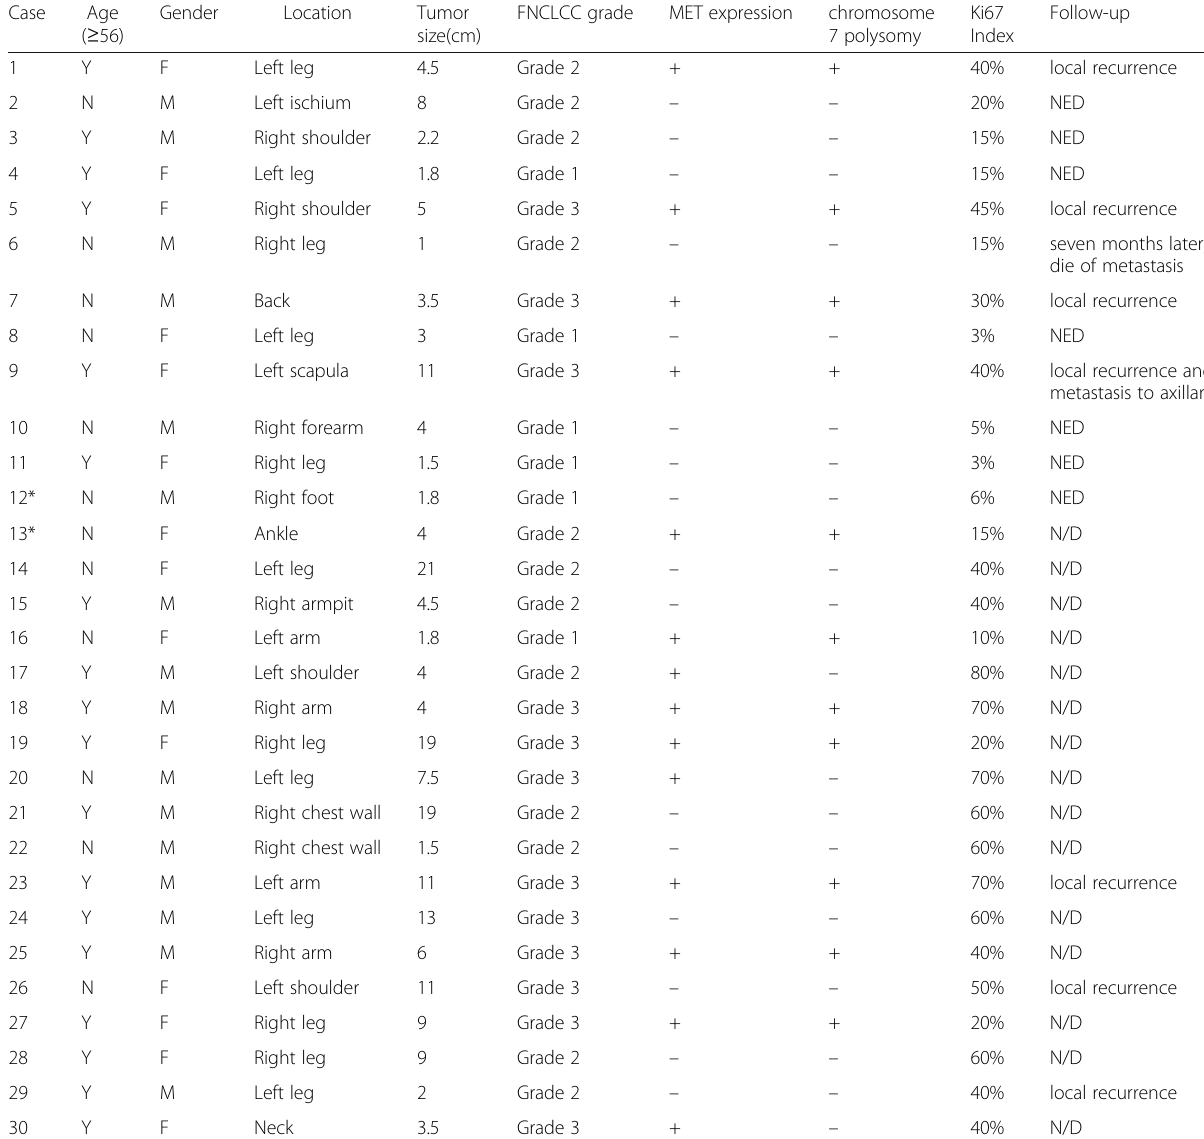
Table 1 Clinicopathological characteristics of 30 MFS cases